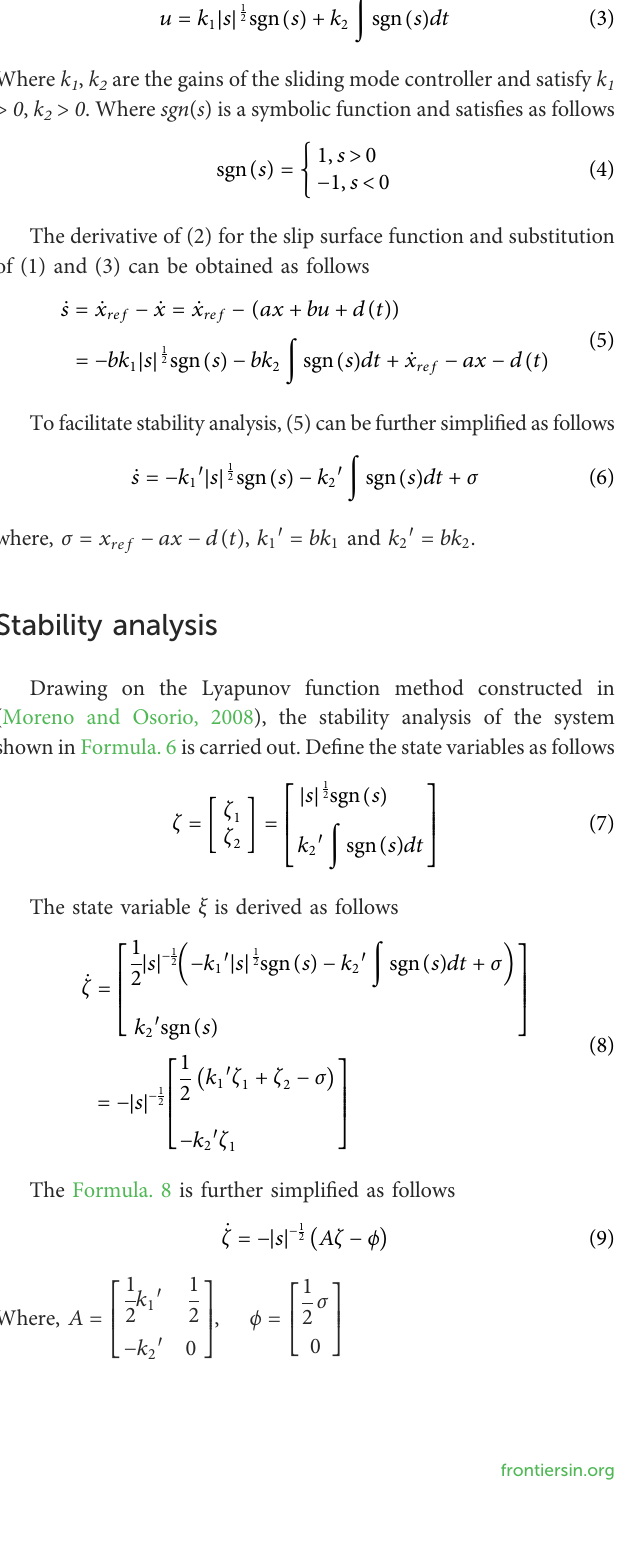
FIGURE 1 Control block diagram of single neuron adaptive sliding mode